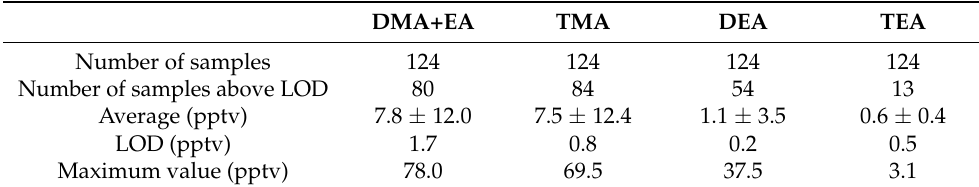
period, with average concentrations of 7.8 ± 12.0 and 7.5 ± 12.4 pptv, respectively. The average concentration of DEA was 1.1 ± 3.5 pptv and the average concentration of TEA was 0.6 ± 0.4